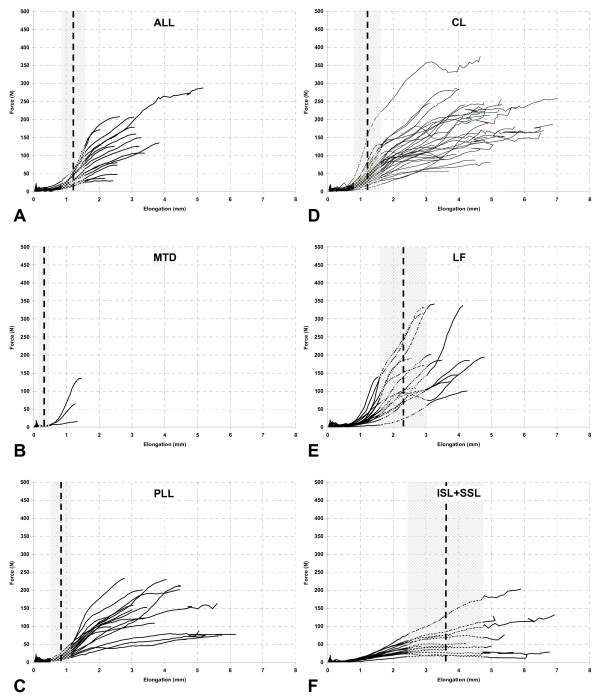
Ligament force vs. elongation curves, including the average physiological elongation shown by a vertical dashed line, and the physiological ligament elongation range (average ± SD), indicated by grey shading. The ligaments included A) anterior longitudinal ligament (ALL), B) middle-third disc (MTD), C) posterior longitudinal ligament (PLL), D) capsular ligament (CL), E) ligamentum flavum (LF), and F) interspinous and supraspinous ligaments (ISL+SSL).